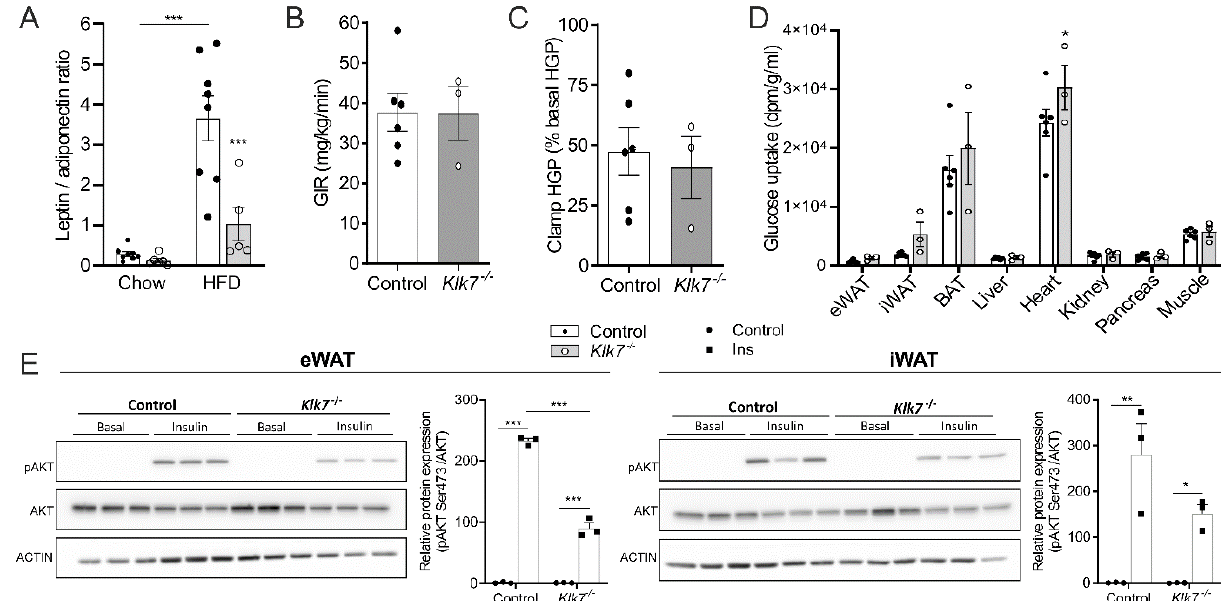
Figure 6. Whole body and tissue insulin sensitivity in chow-fed Klk7 −/− mice. ( A ) Leptin to adiponectin ratios for chow and HFD fed mice as proxy for adipose tissue function indicate improved metabolic state/health in lean and obese Klk7 −/− mice compared to controls (chow n = 8/8, HFD n = 8/5, controls and Klk7 −/− ). ( B ) Glucose infusion rate (GIR in mg/kg/min) during clamp was not different in chow-fed KLK7 −/− mice compared to controls mice ( n = 6/3). ( C ) Hepatic glucose production (HGP) during clamp (as % from basal HGP) is not affected by the genotype ( n = 6/3). ( D ) Tissue glucose uptake (dpm/g/mL) is significantly higher in hearts of Klk7 −/− mice compared to controls ( n = 6/3). ( E ) Insulin-induced AKT phosphorylation analyzed by Western blot in differentiated primary adipocytes from eWAT (left) and iWAT (right) from three animals per genotype. Densitometric quantification of bands is presented next to the blots. Phosphorylation of AKT by insulin is significantly dampened in all primary adipocytes from Klk7 −/− mice. Data are presented as means ± SEM; significance was tested by Student’s t -test ( A – C ), uncorrected multiple t -tests ( D ) or two-way ANOVA with correction for multiple testing (Tukey; ( E )); * p < 0.05, ** p < 0.01, *** p < 0.001.